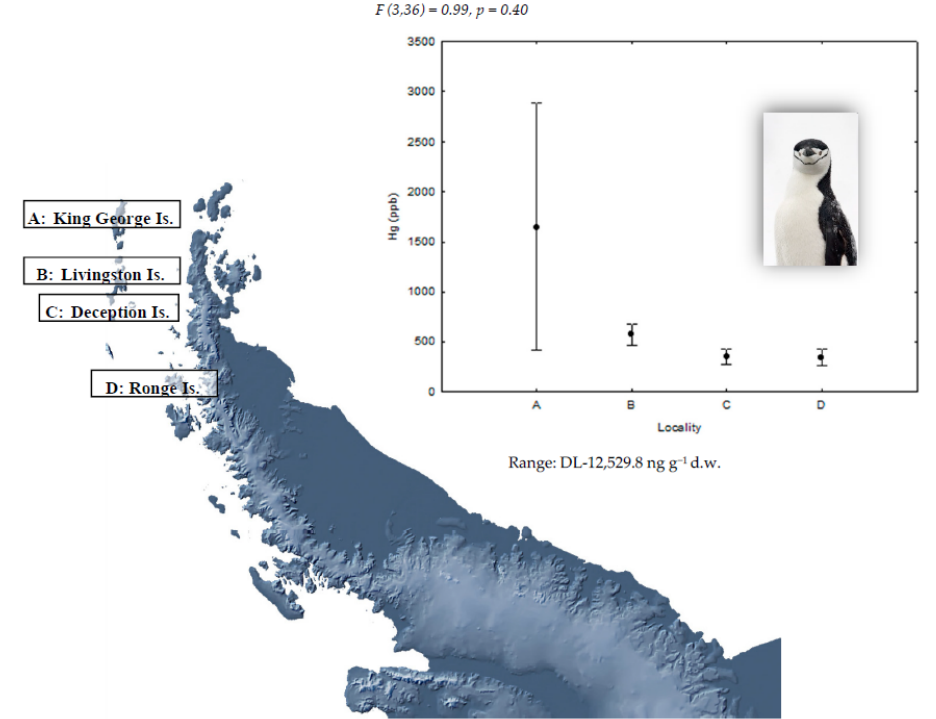
Figure 2. Mean ( ± SE) Hg concentration in feathers of chinstrap penguins ( P. antarcticus ) in four locations of the Antarctic Peninsula area. For sample sizes, see Table 1. DL: detection limit.